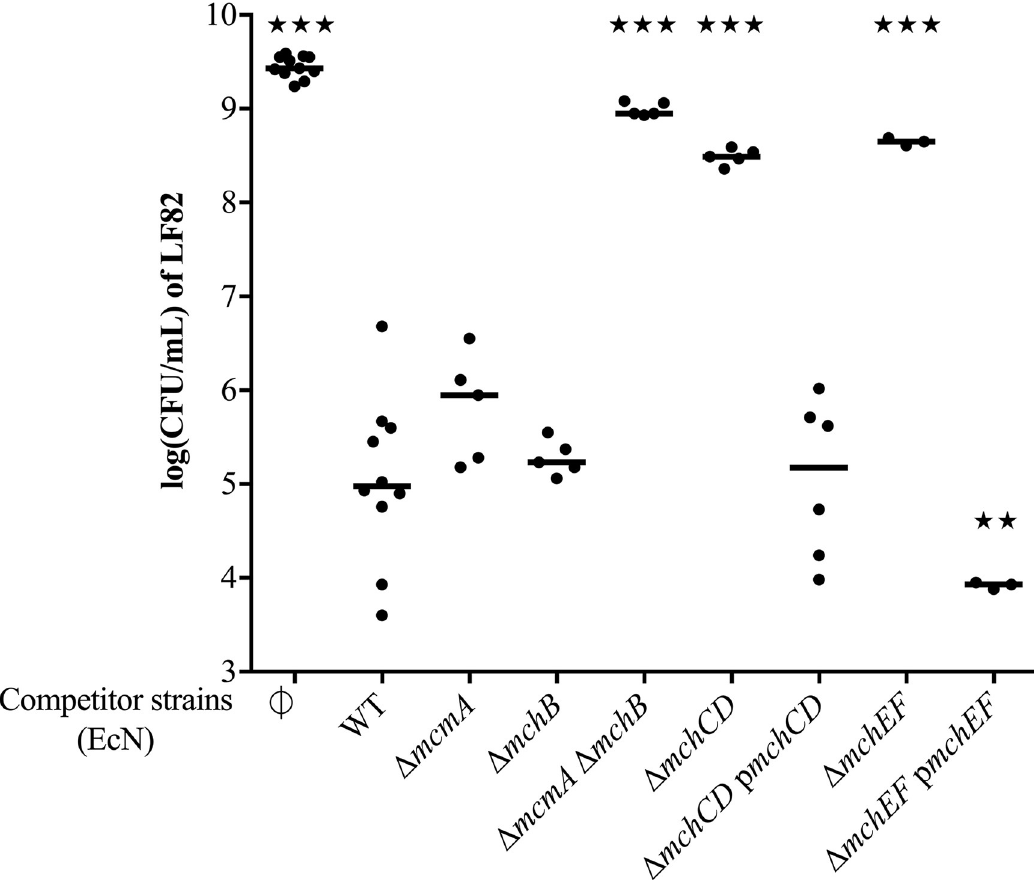
Fig 2. Role of the microcin gene cluster in EcN antibacterial activity on LF82. Colony forming unit (CFU) counts of E . coli LF82 following a 24-hour co-culture in M63 medium with wild-type (WT) E . coli strain Nissle 1917 (EcN), EcN mutant for microcin M (MccM) precursor gene mcmA , for microcin H47 (MccH47) precursor gene mchB , for both mcmA mchB genes; EcN mutants and complemented strains for mchC mchD genes responsible for posttranslational modifications, and for mchE mchF genes that encode the MccM and MccH47 efflux pump. LF82 was also cultured alone as a control ( ∅ ). The medians and individual results of independent experiments are shown. One-way ANOVA and Bonferroni post-tests in comparison with co-culture with WT; $ $ P < 0.01; $$$ P <